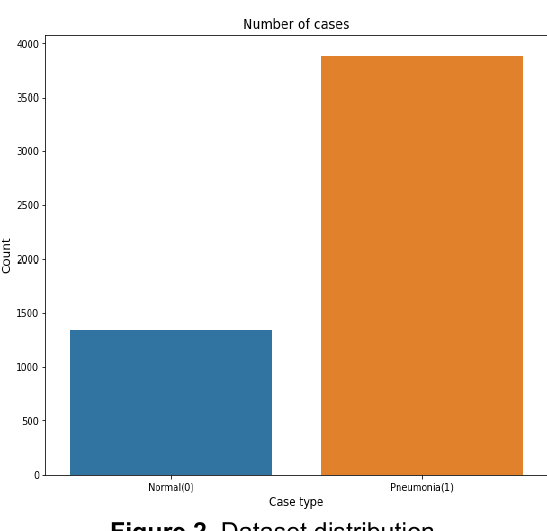
Figure 2. Dataset